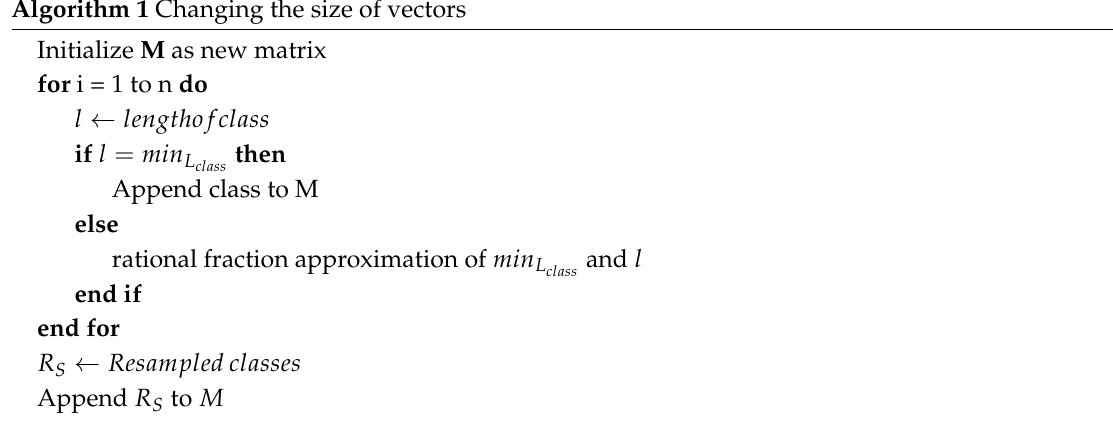
Algorithm 1 Changing the size of